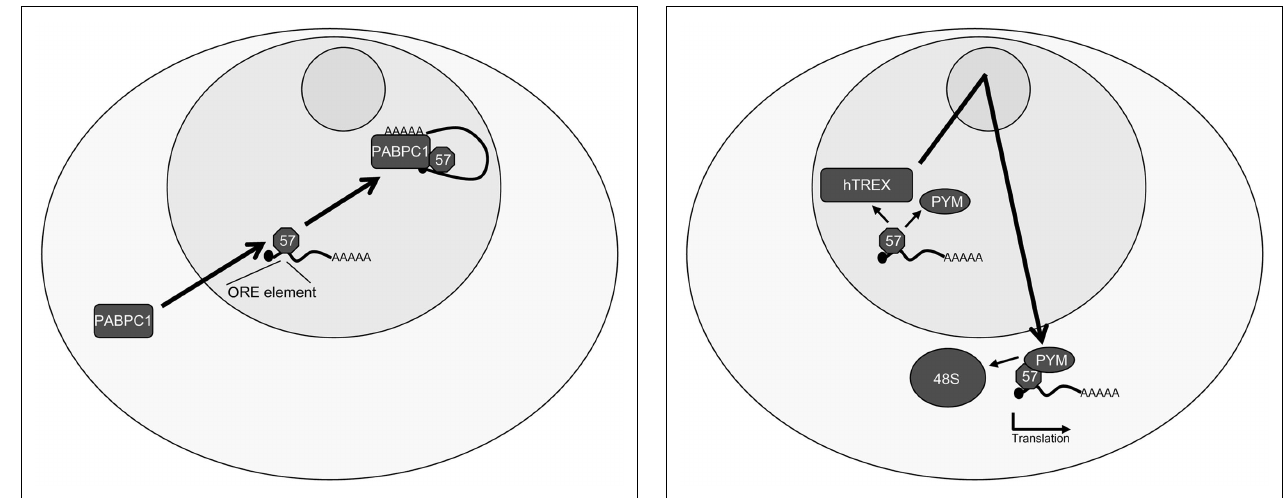
FIGURE 4 | Kaposi’s sarcoma-associated herpesvirus ORF57 stabilizes PAN RNA in the nucleus. ORF57 binds to the ORF57 response element (ORE) in the 5 (cid:2) of the KSHV PAN RNA, stabilizing PAN, and increasing expression. Additionally, ORF57 is able to redistribute PABPC1 to the nucleus, as well as PABPC1 being able to bind to the ORE, possibly explaining the stabilizing ability of the ORF57–PABPC1 interaction on PAN RNA.